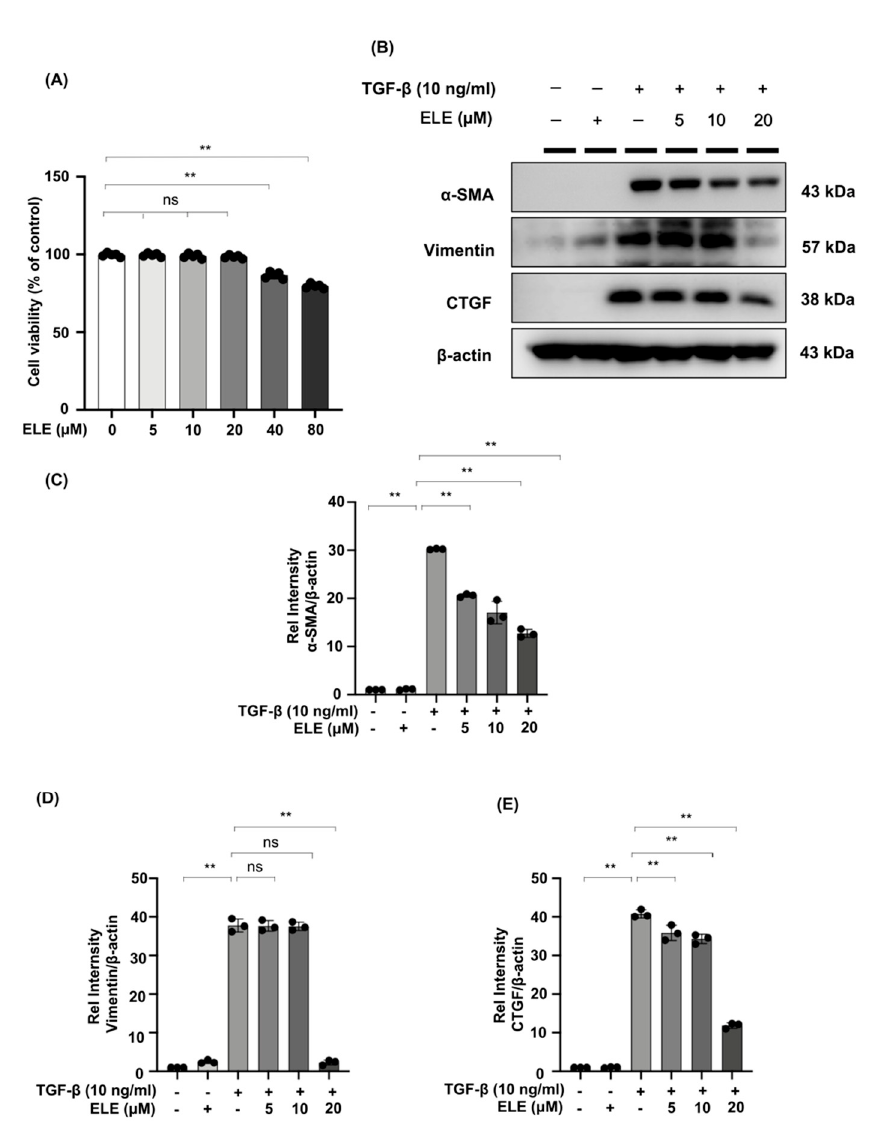
Figure 3. β -elemene inhibited TGF- β stimulated fibroblast activation in NRK49F cells. ( A ) Cells were treated with β -elemene for 24 h, and cytotoxicity assays were conducted. ( B ) Expression of α -SMA, CTGF, and vimentin in TGF- β stimulated NRK49F cells was detected by western blot and quantified by densitometry in a dose-dependent manner. Cells were pre-treated with β -elemene for 2 h after starvation with 0.5% FBS medium, treated with TGF- β (10 ng/mL) for 30 min, and incubated in 5% FBS medium for 24 h. ( C – E ) The Statistical significance was presented as the mean ± SD, n = 3. ** p < 0.01, ns: no significance. ELE, β